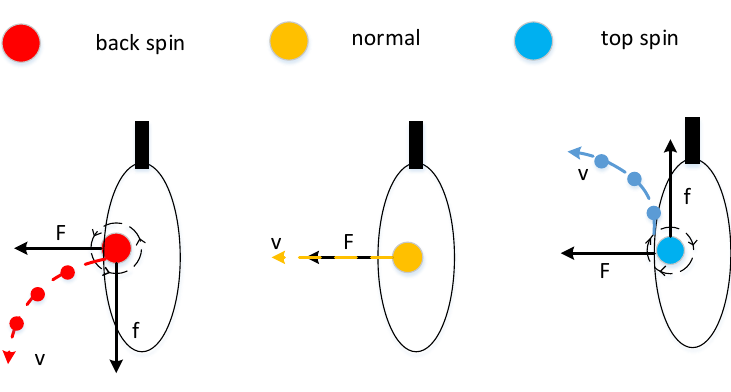
Figure 20. The track of the spinning ball after hitting the